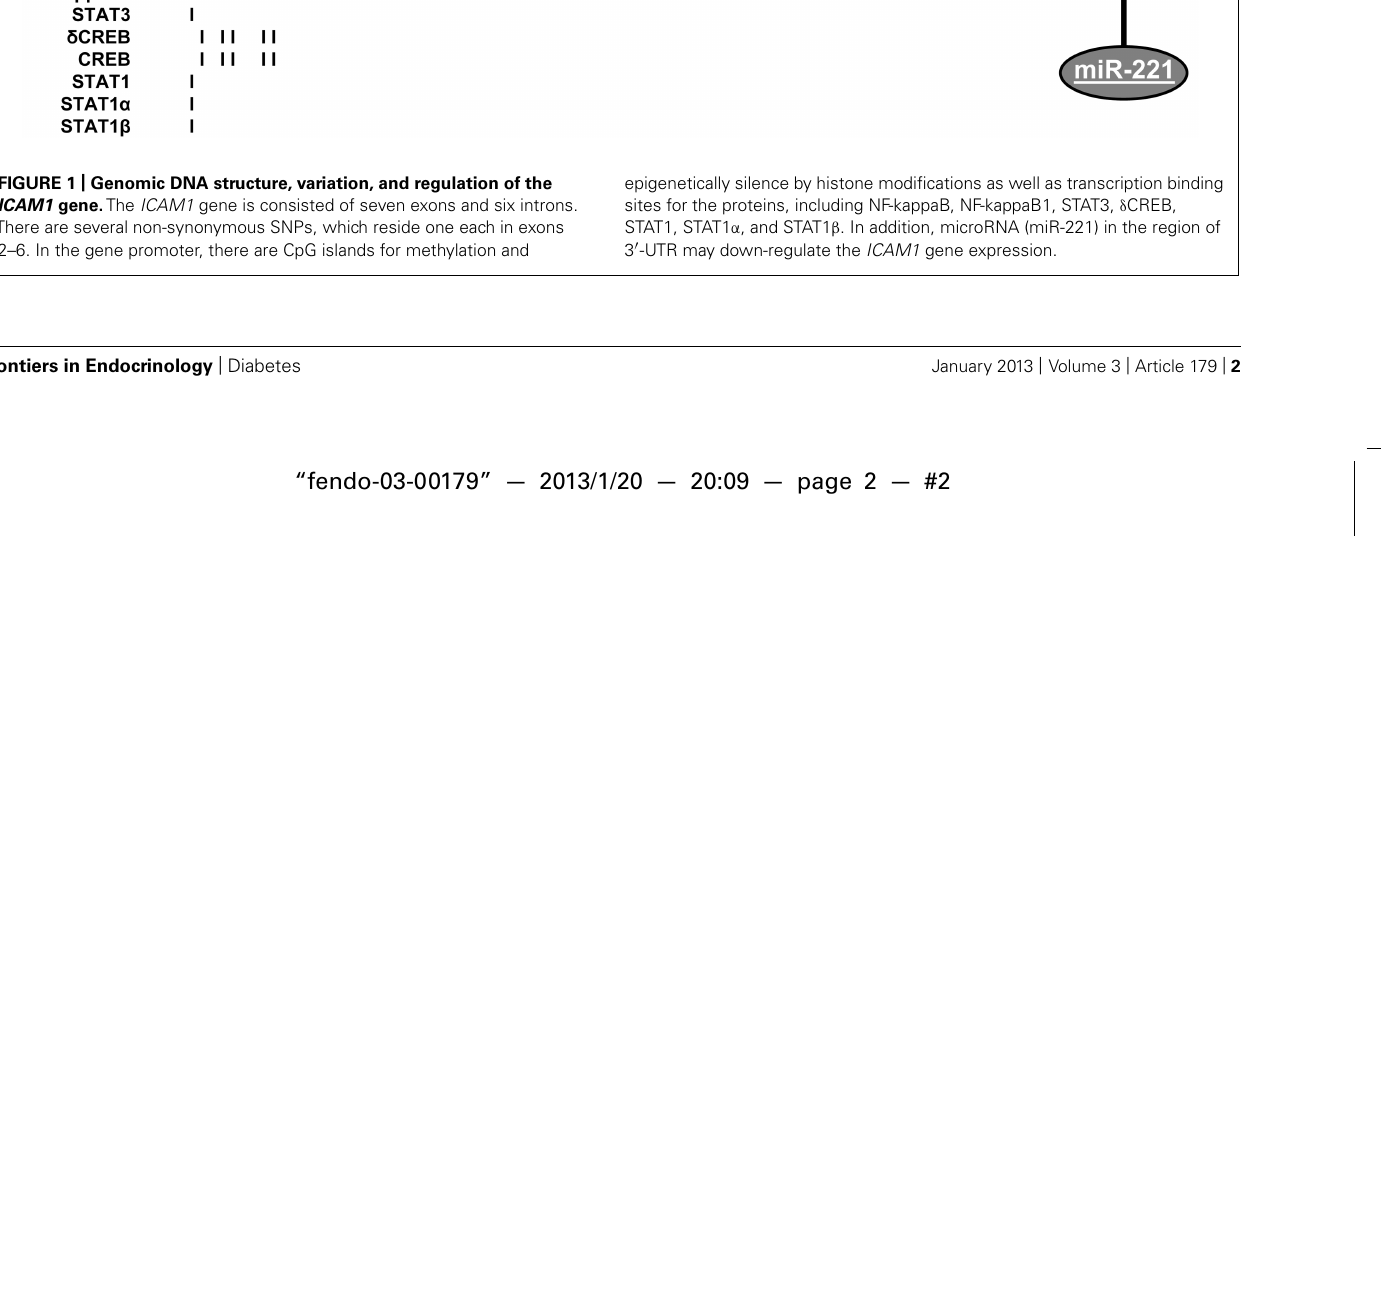
epigenetically silence by histone modifications as well as transcription binding sites for the proteins, including NF-kappaB, NF-kappaB1, STAT3, δ CREB, STAT1, STAT1 α , and STAT1 β . In addition, microRNA (miR-221) in the region of 3 (cid:2) -UTR may down-regulate the ICAM1 gene